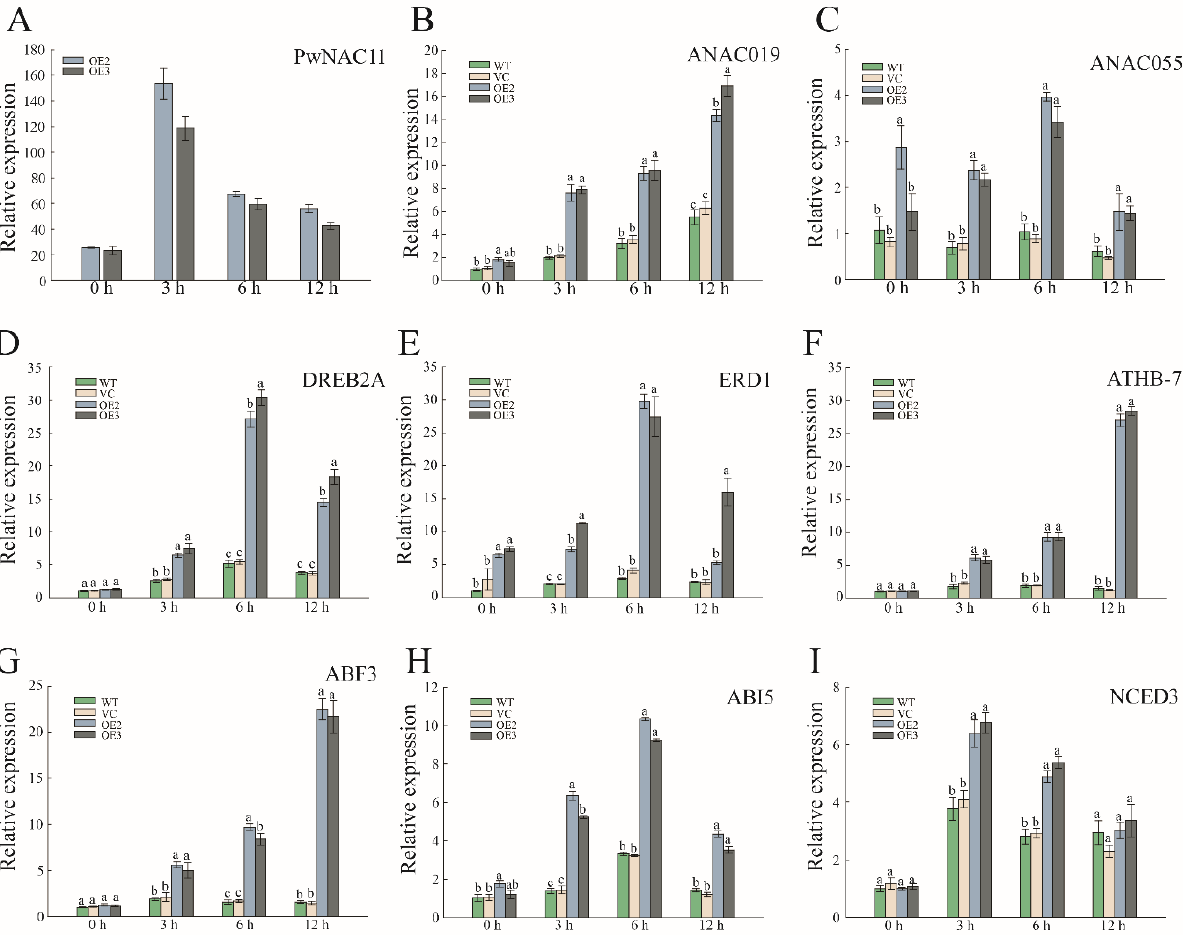
Figure 5. Expression profiles of some stress-responsive genes and ABA-responsive genes after PEG treatment. ( A – I ) Expression profiles of these genes in OE, WT, and VC lines under simulated drought conditions. The data are represented as means ± standard error from three independent replications. Different letters indicate significant differences at p -value < 0.05.